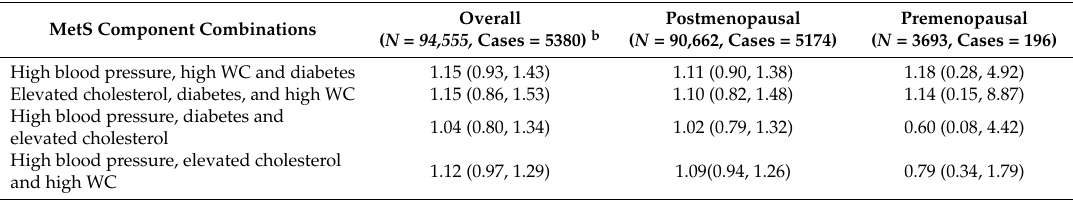
Table 5. Association between combinations of MetS components and breast cancer risk by menopausal status (HR, 95% CI).